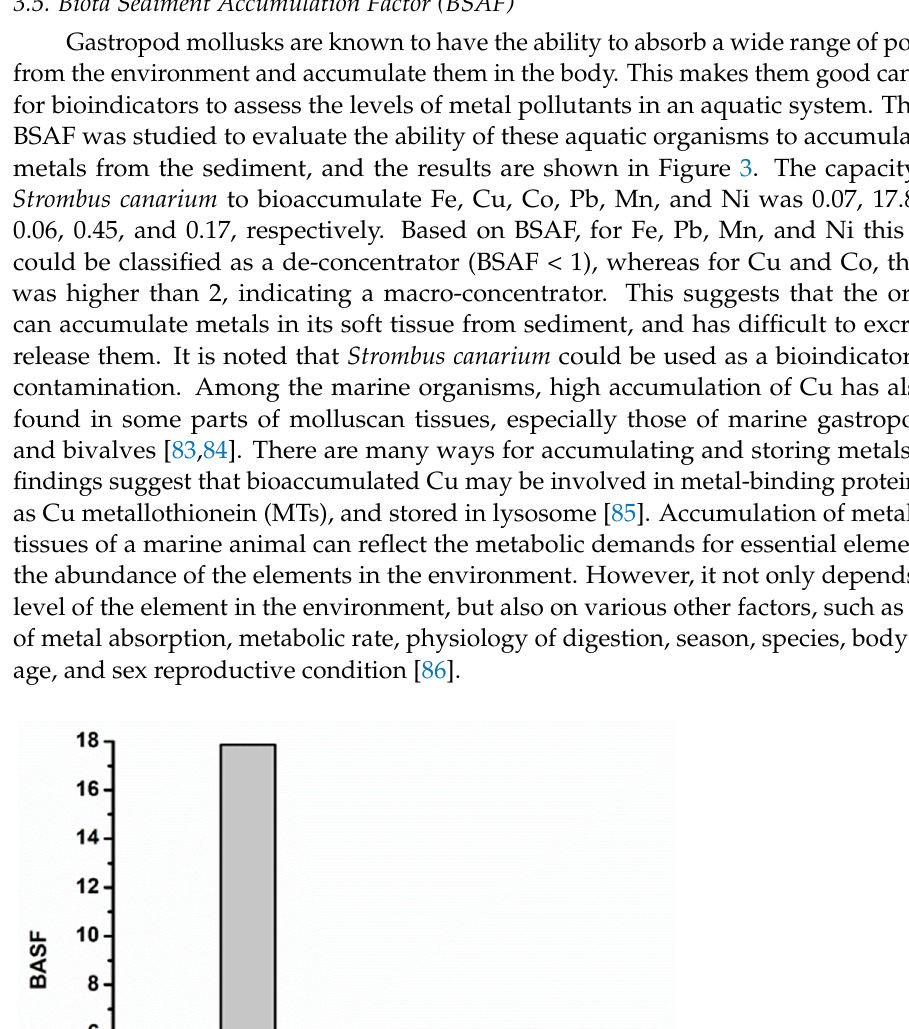
Table 5. Correlation between metal concentrations in sediment and soft tissue of shellfish.